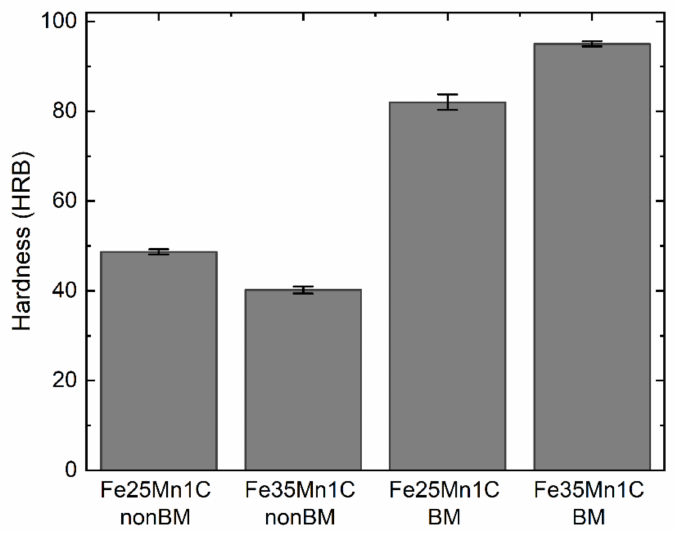
Figure 4. Hardness of FeMnC